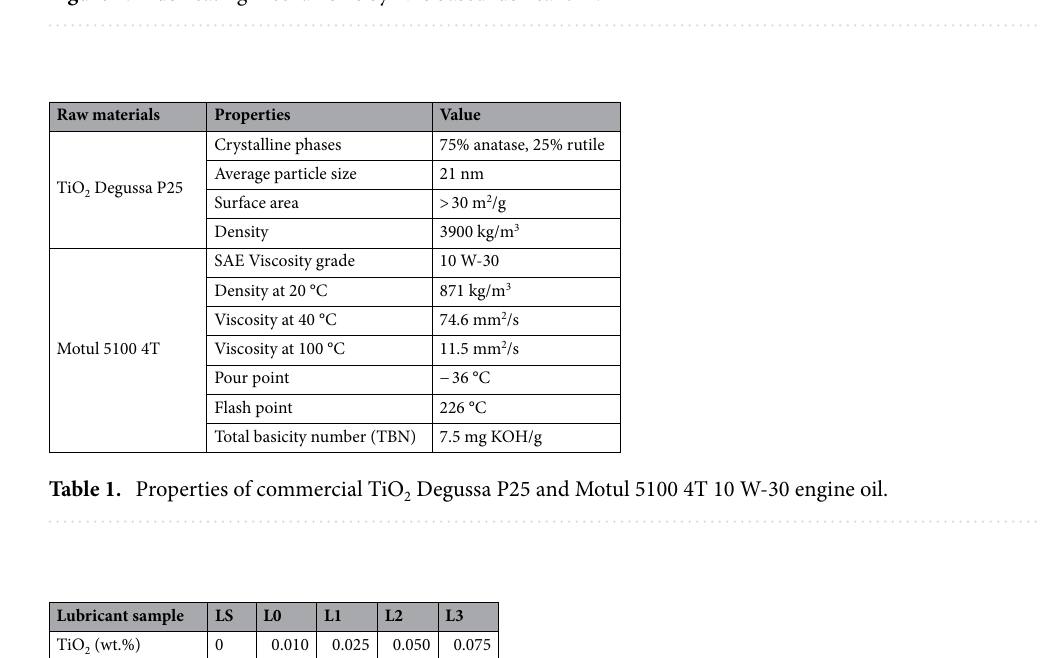
Figure 1. Lubricating mechanisms by NPs based lubricant 5,15 .